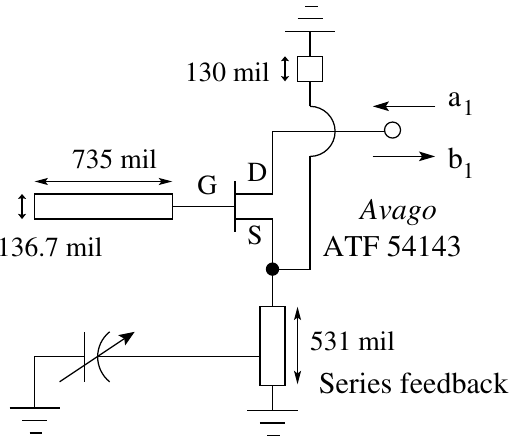
Figure 5. Schematic of the negative-conductance active circuit. The width of all the microstrip lines is 136.7 mil. RT/Duroid 5880 with ε r = 2.2 and thickness h = 45 mil is used for the substrate.